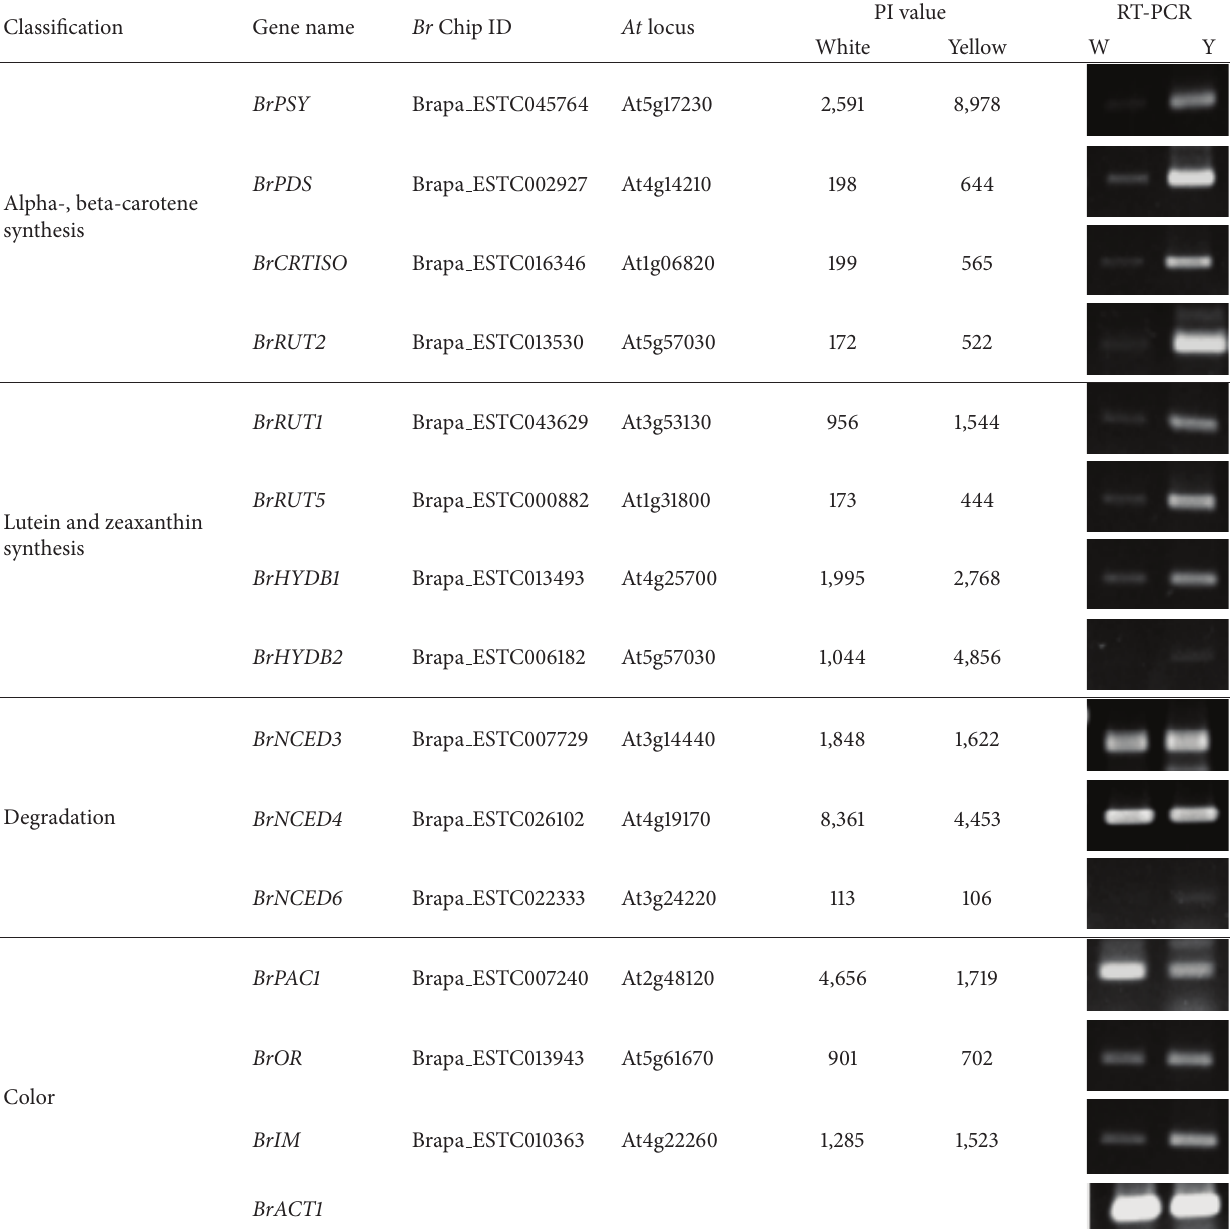
Table 2: Carotene and lutein synthesis-related